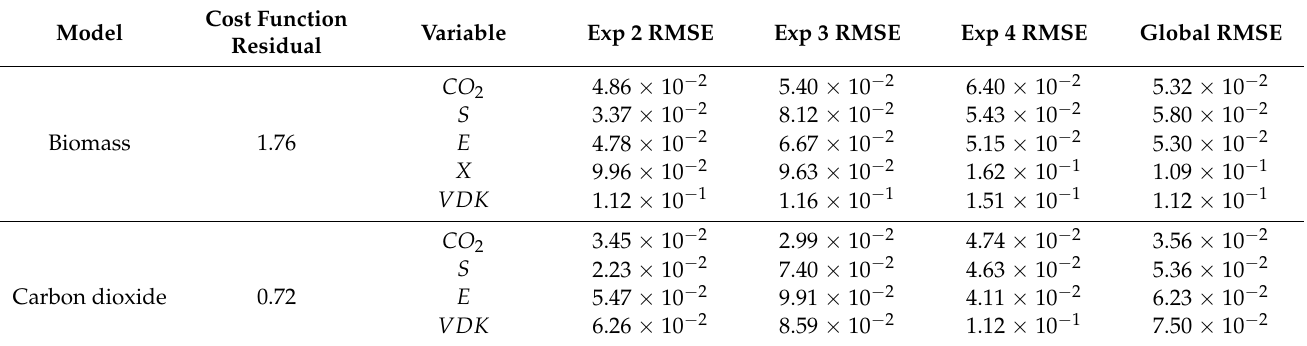
Table 7. Cost function residuals and relative RMSEs for each state variable of the two models, resulting from direct validation.